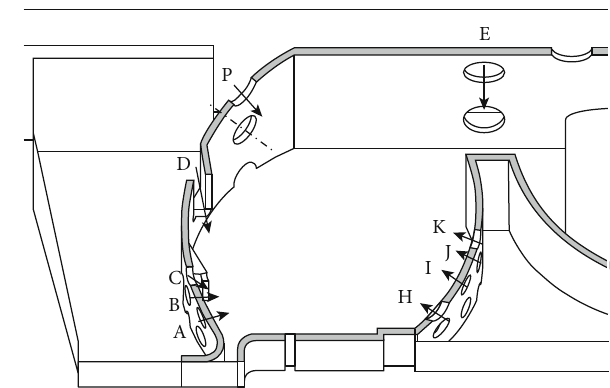
Figure 8: Schematics of the combustor liner